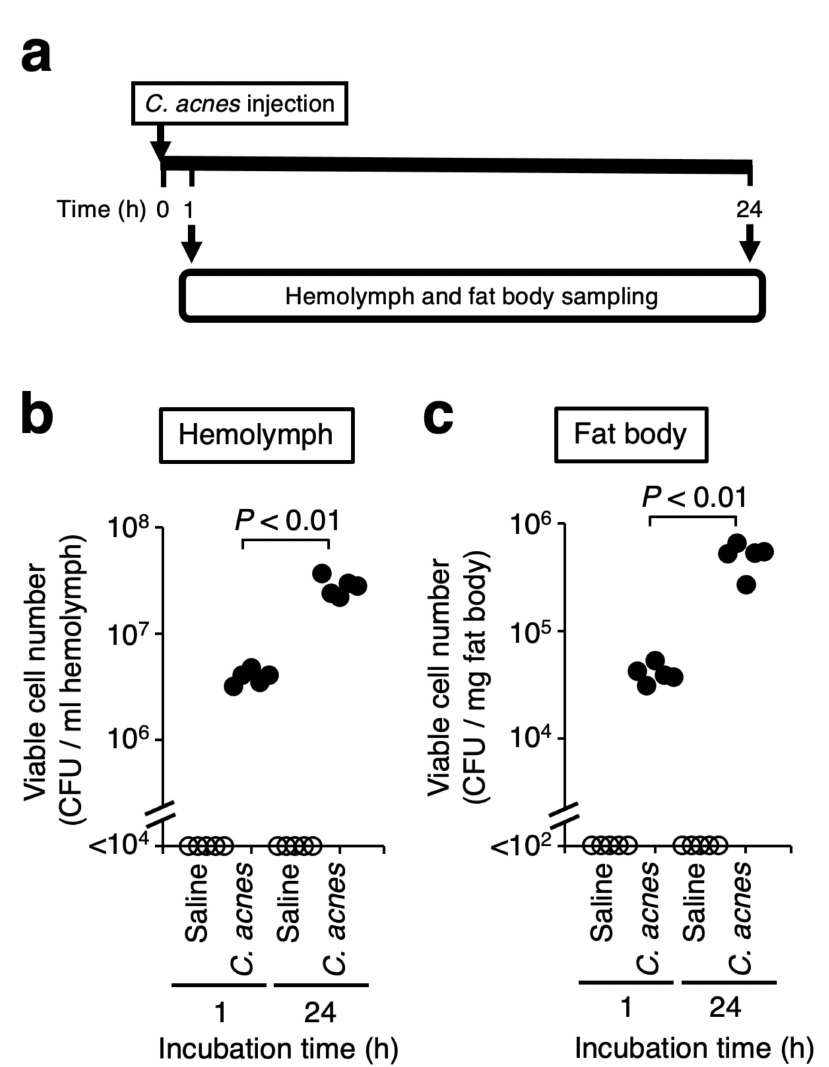
Figure 3. Increase in viable cell number of C. acnes in silkworms. ( a ) Scheme of the experiment. Silkworms were injected with saline or C. acnes cell suspension (3.3 × 10 8 cells/50 µ L) and incubated at 37 ◦ C. Hemolymph ( b ) and fat body ( c ) were harvested from the silkworms at 1 or 24 h after injection. Viable cell number of C. acnes in the samples was measured by counting the colony-forming unit (CFU). Statistically significant differences between groups were evaluated using Student t -test. n = 5 /